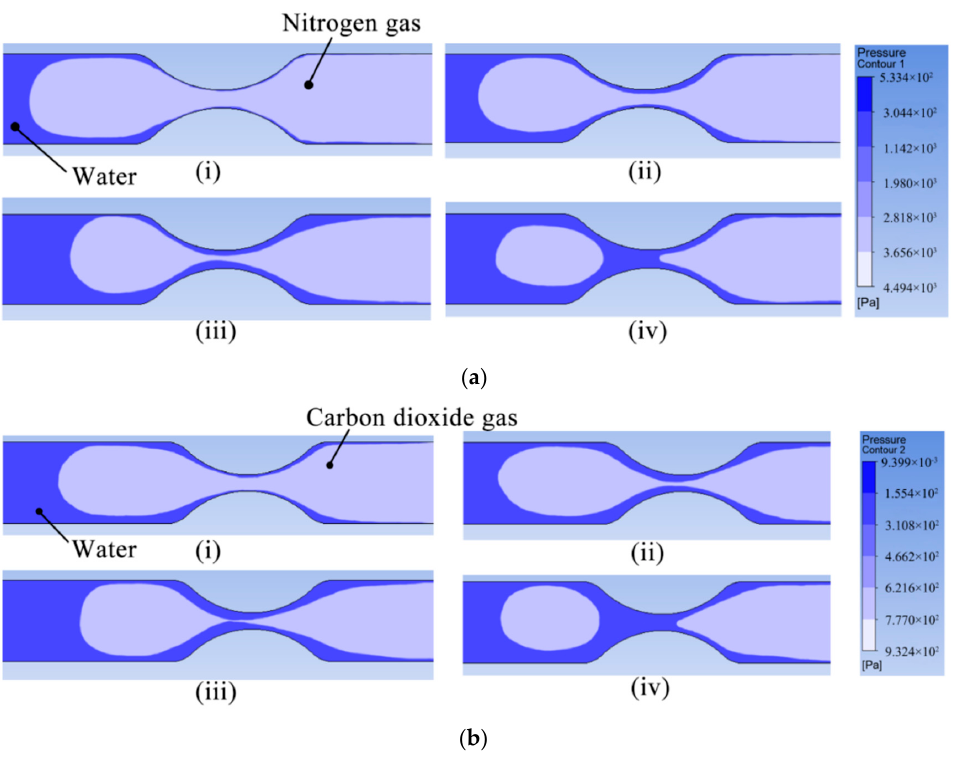
Figure A1. Pressure Contour (Pa) from Numerical Simulation for Axisymmetric Pore Throat: ( a ) Nitrogen Gas ( b ) Carbon Dioxide Gas.